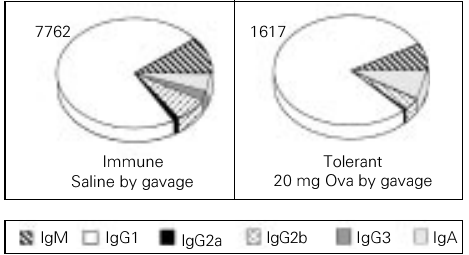
Figure 2 - Oral tolerance drasti- cally reduces the magnitude of anti-ovalbumin (Ova) immune re- sponses, but preserves the isotypic profile of the antibodies formed. Mice were treated as described in the legend to Fig- ure 1. The numbers above the pies denote the global ELISA score for the group. Each sec- tion of the pie represents the percentage of each isotype in the overall antibody titer. Note that IgG1 and IgG2a antibodies are equally suppressed in the tolerant